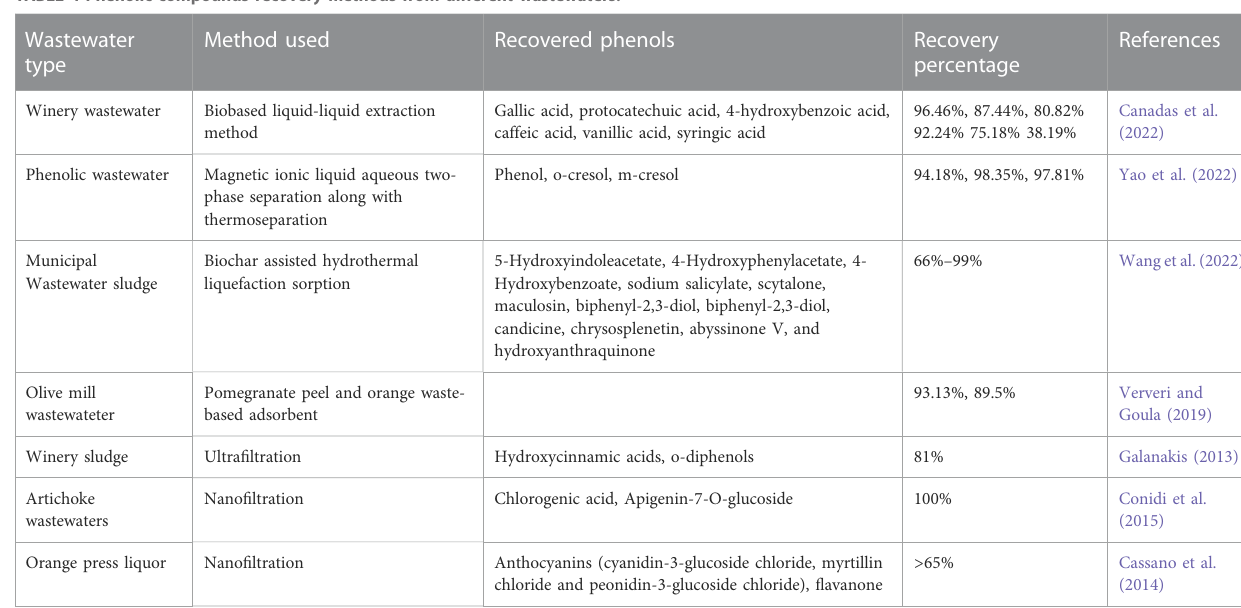
TABLE 4 Phenolic compounds recovery methods from different